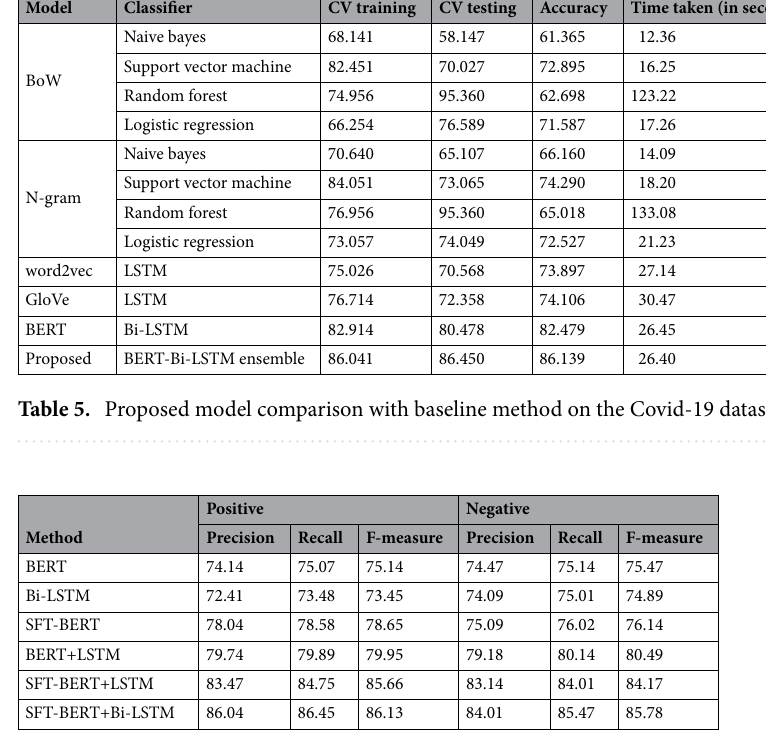
Table 6. The proposed model with several variations comparative result in analysis on the Covid-19 dataset.